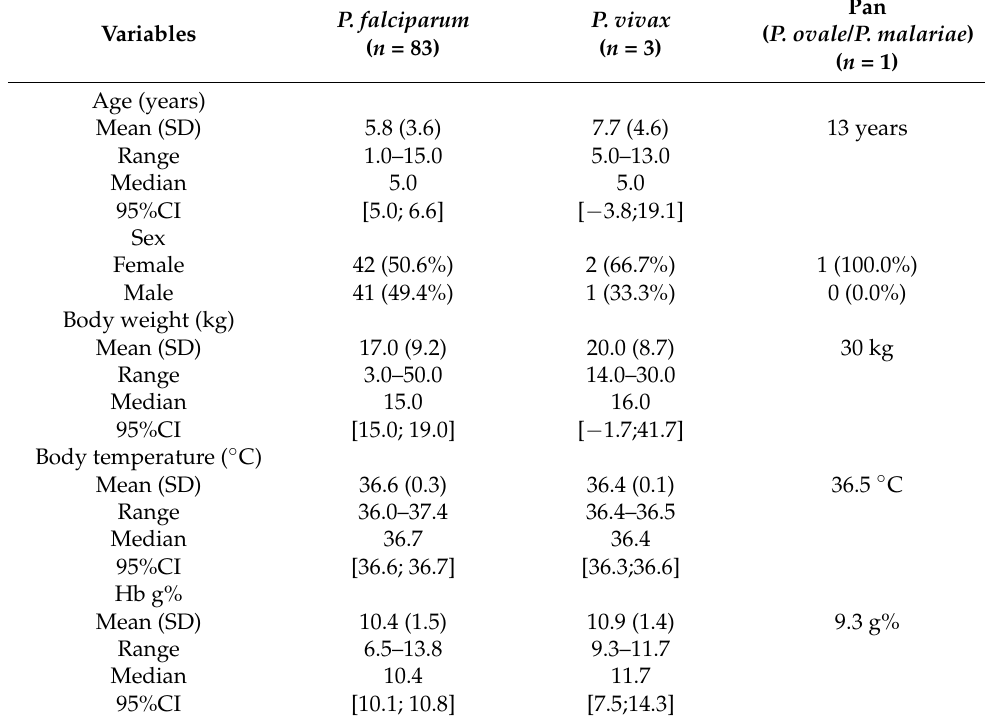
Table 3. Children with mRDT (+) ( n = 83).